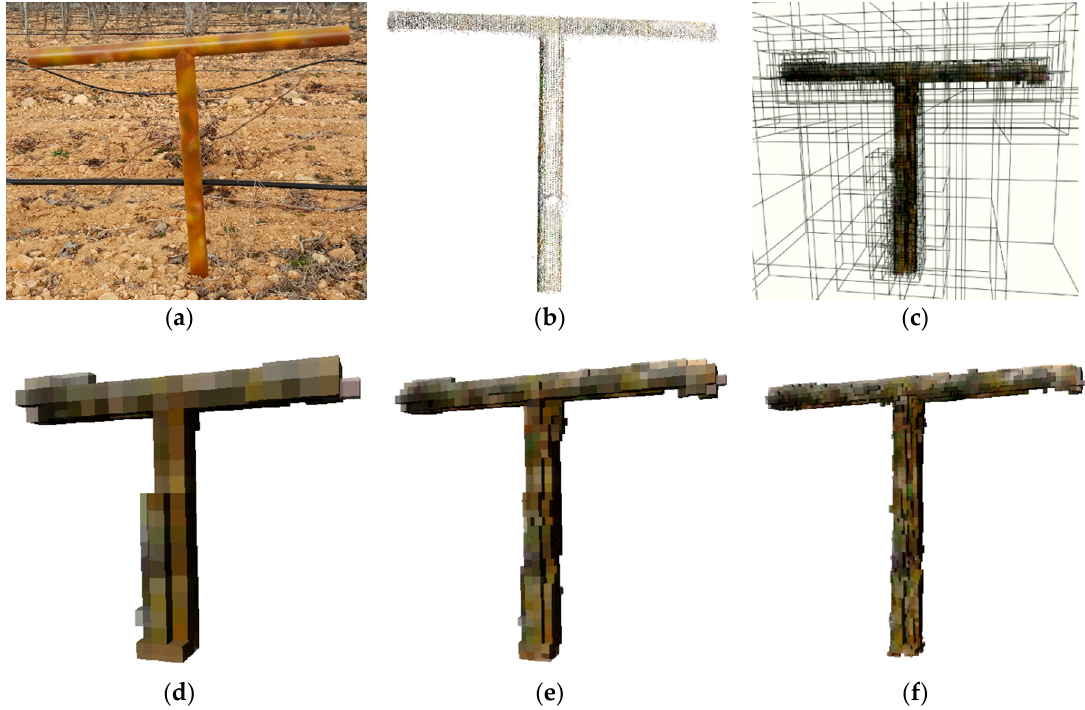
Figure 8. Example of VSAOs at voxel resolutions. ( a ) Real VSAO. ( b ) 3D point cloud from TLS. ( c ) Voxelization. Voxel resolutions of ( d ) 0.04; ( e ) 0.02; and ( f ) 0.01 m.